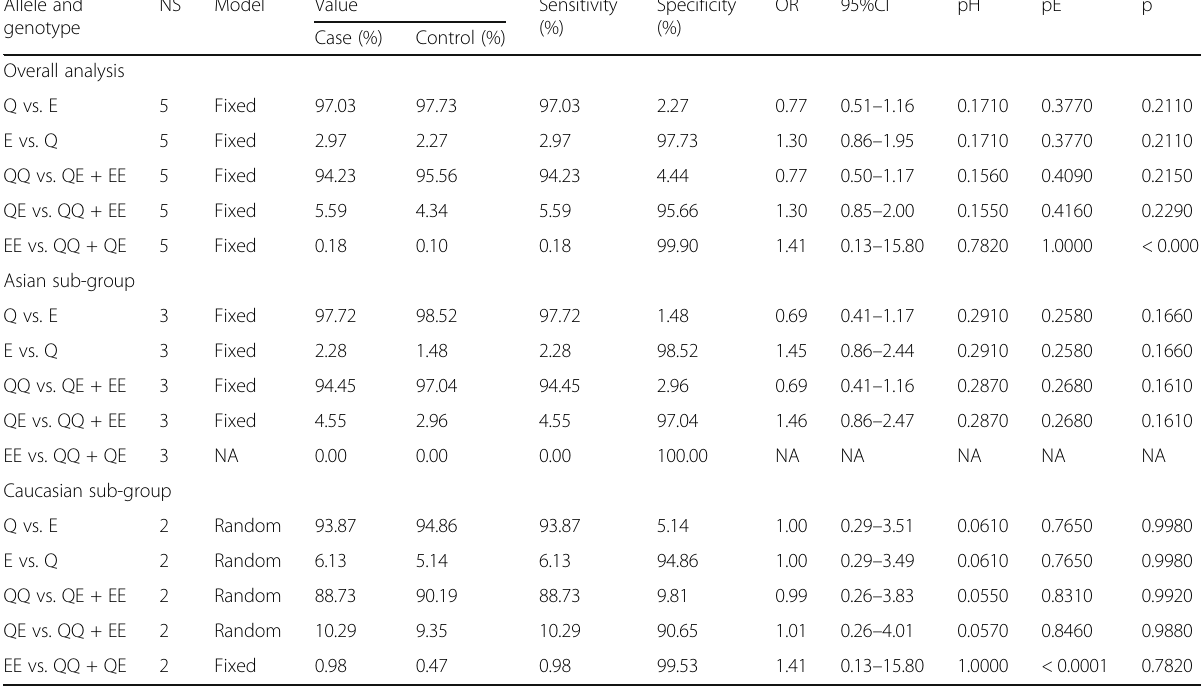
Table 6 Summary of the association between Q1011E gene polymorphism and the risk of urolithiasis Allele and